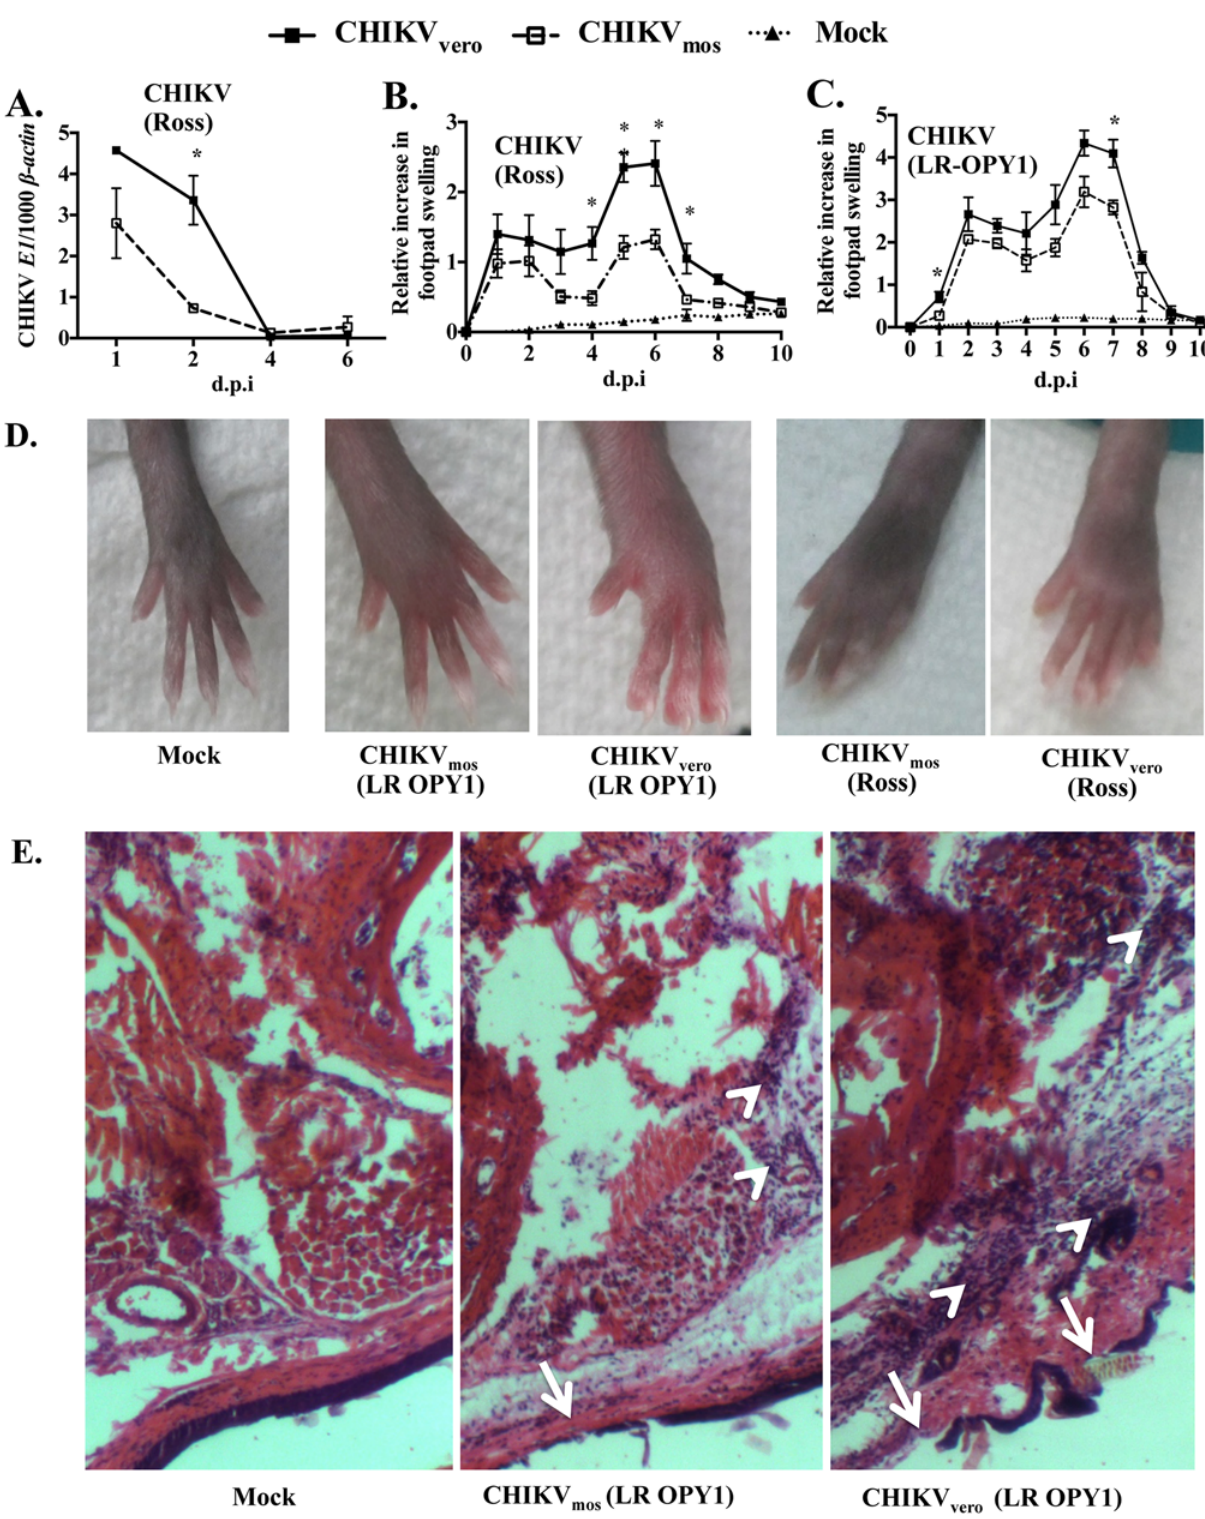
Fig 4. CHIKV mos produces lower levels of viremia and footpad swelling in mice. Wild-type C57BL/6J mice were subcutaneously infected with 1 × 10 5 PFUs of CHIKV vero , CHIKV mos or mock infected with PBS and monitored daily for 10 days. (A) Viral load in blood at day 1, 2, 4 and 6-post infection (d.p.i) with CHIKV (Ross strain) is presented as ratio of CHIKV E1 copy number per 1000 copy of cellular β -actin . Swelling of hind footpad (perimetatarsal area) of